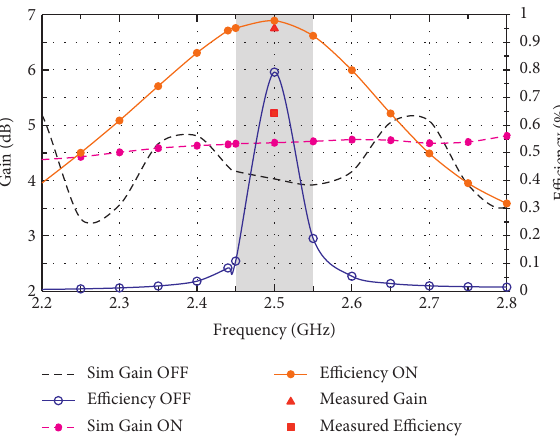
Figure 15: Antenna gain and efficiency.